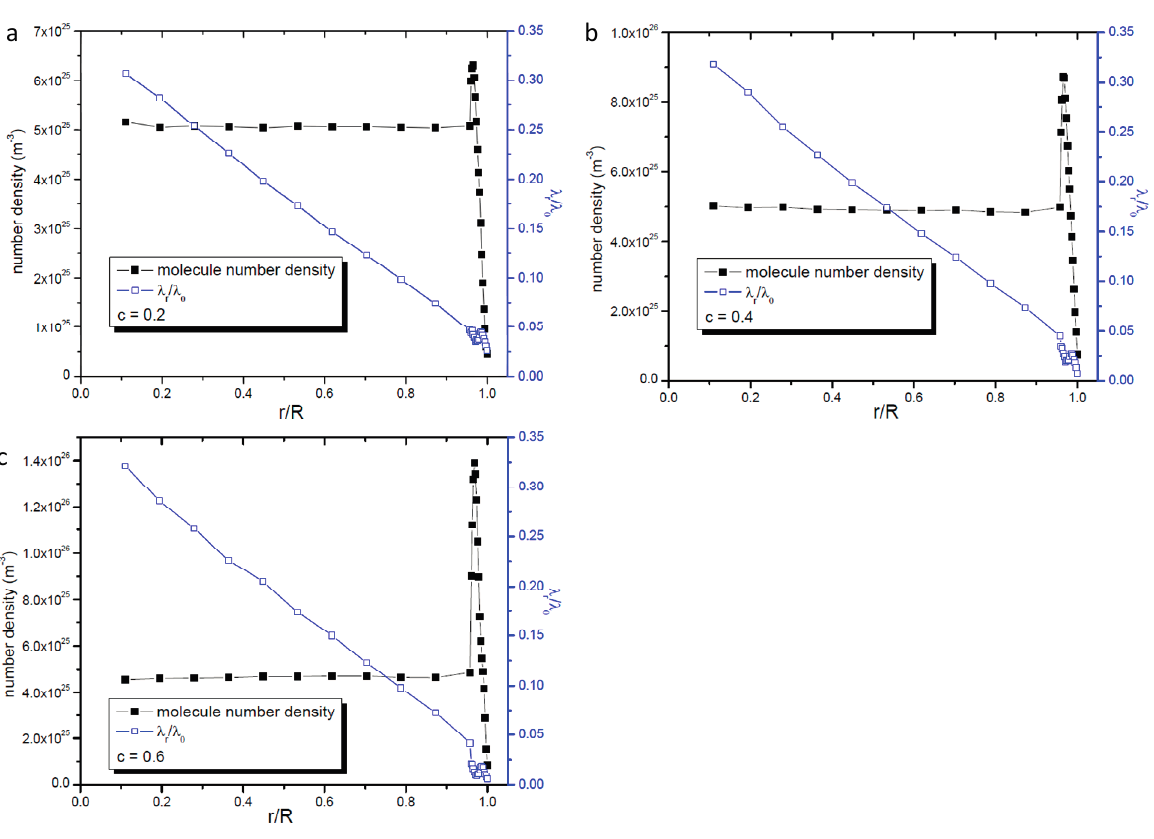
Figure 7. Profiles of radial gas molecular mean free path and gas number density. ( a ) c = 0.2; ( b ) c = 0.4; and ( c ) c = 0.6.